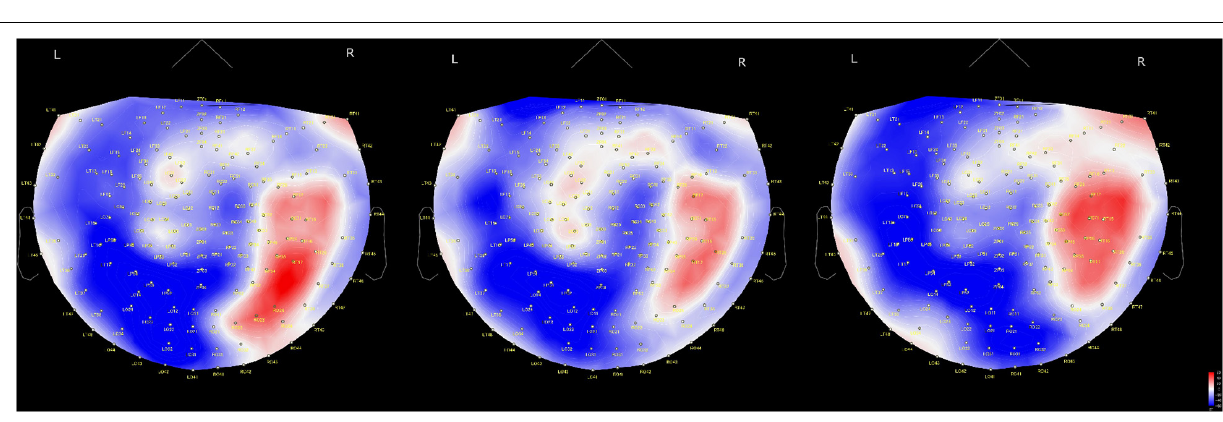
Consistent with this judgment of lying, MBJs similarly activated the left temporal cortex within a shorter duration and with tighter neuronal connections in the neighboring brain